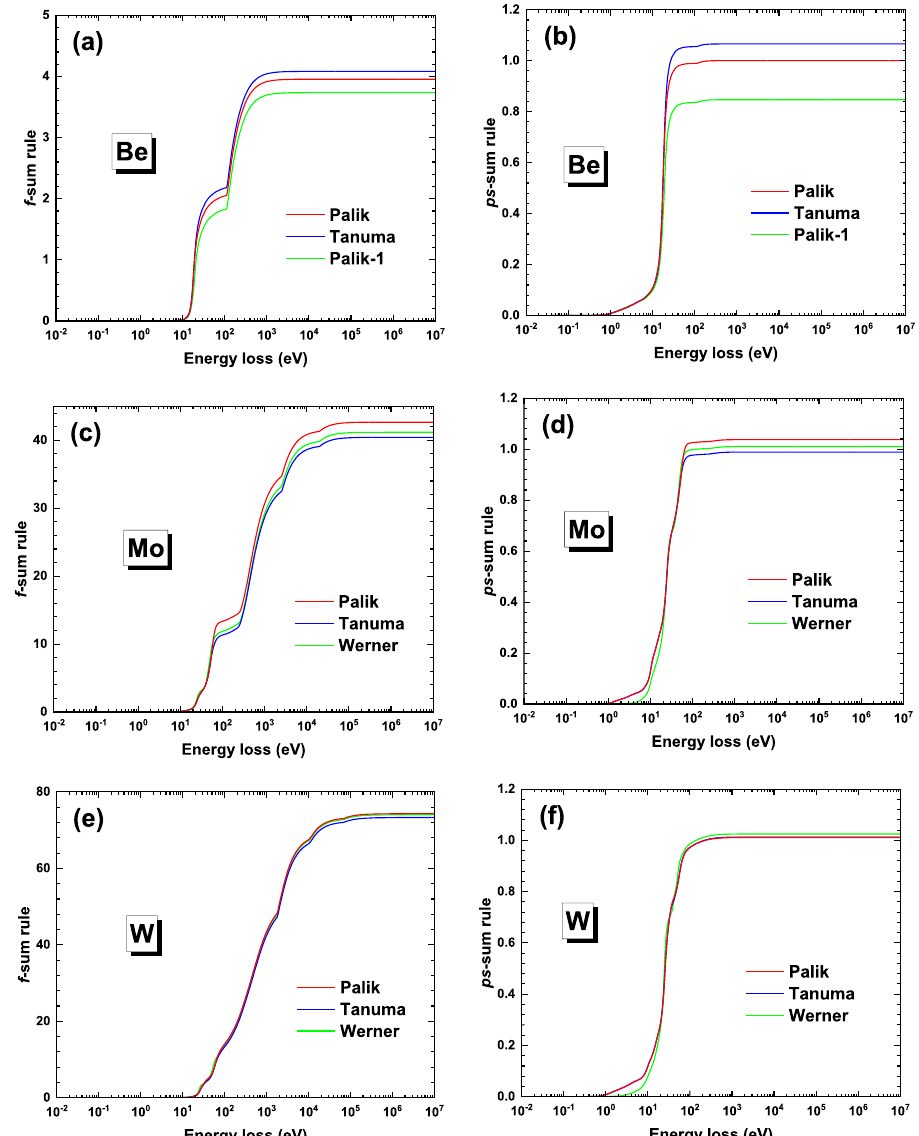
Figure 2. The f - and ps -sum rules for ( a ) ( b ) beryllium, ( c ) ( d ) molybdenum and ( e ) ( f ) tungsten, respectively.